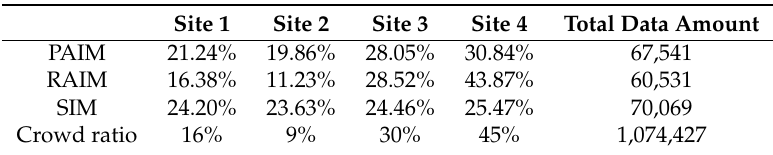
Table 2. Crowd ratios at four task